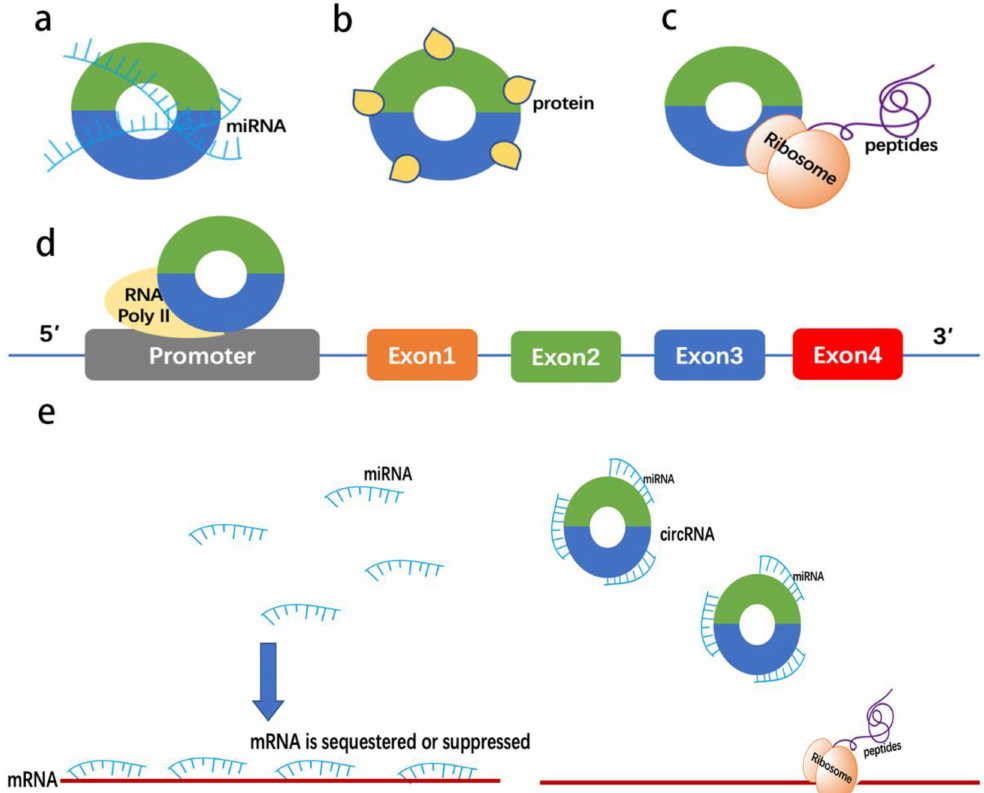
Figure 2. The main functions of circRNAs. ( a ) miRNA sponge; ( b ) protein sponge; ( c ) translating into peptides; ( d ) regulating the expression of the parental gene via interacting with RNA polymerase II and regulating transcription; ( e ) miRNA sponges alleviate the inhibitory effects of miRNAs on target